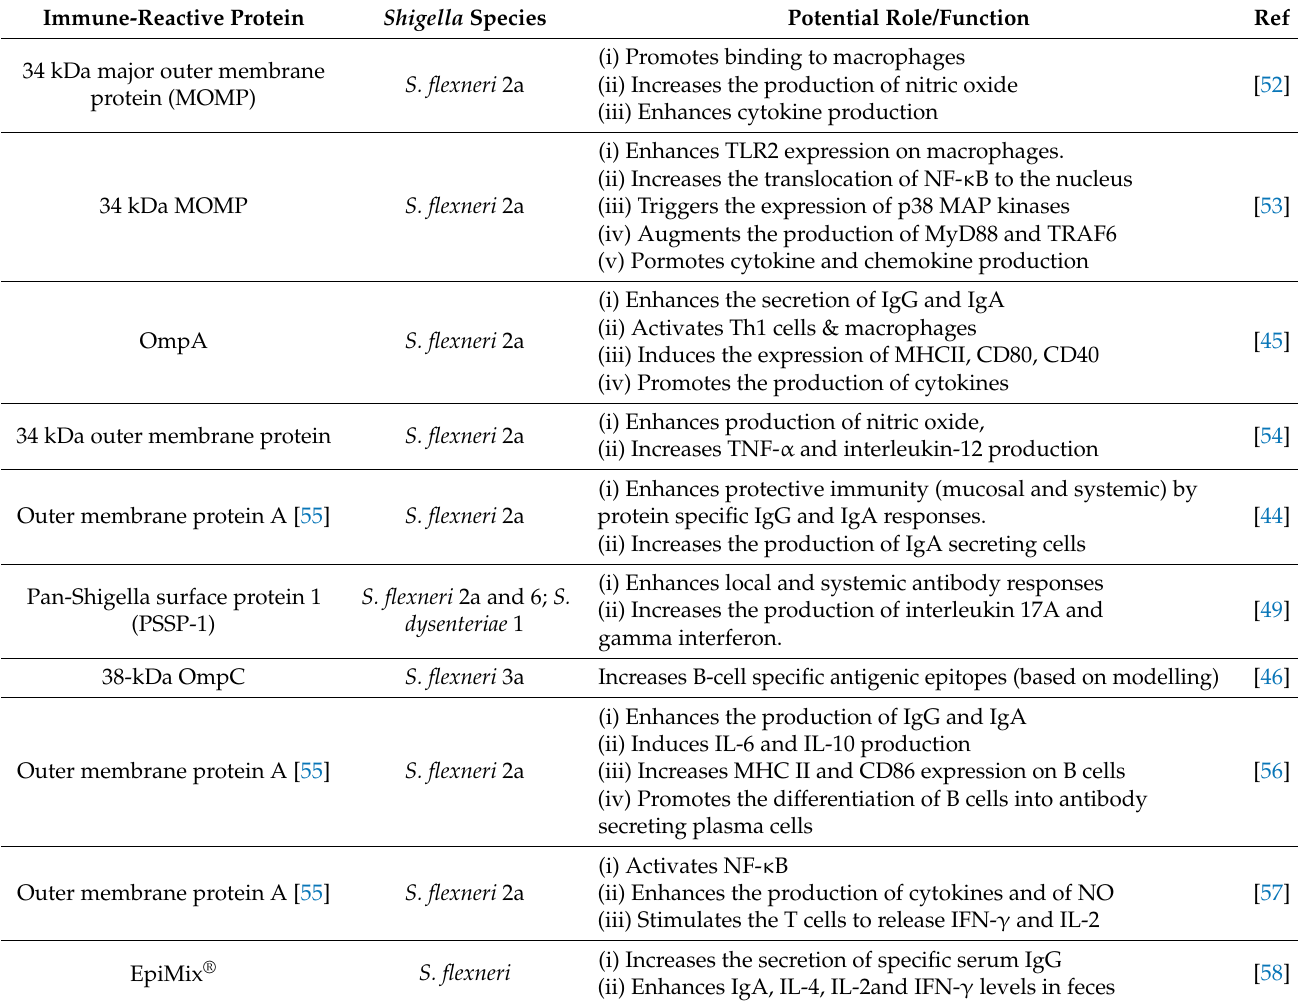
Table 2. Immune-reactive proteins in OMVs from Shigella